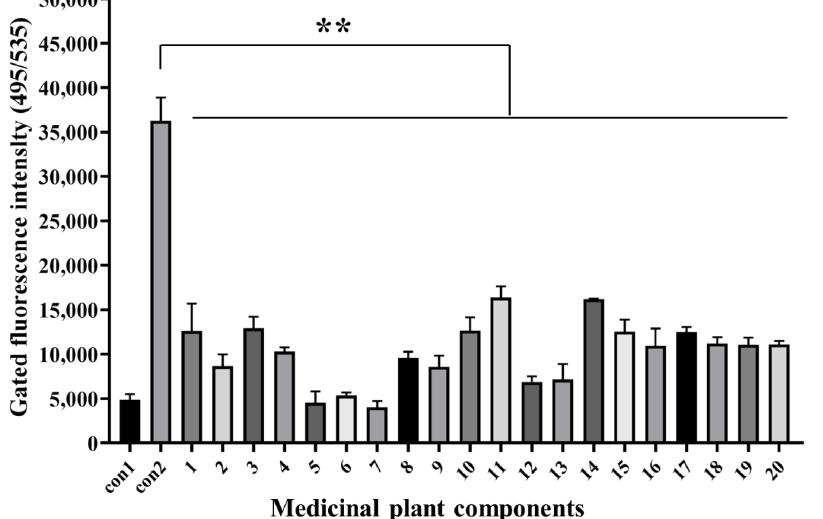
Figure 4. Antiviral analysis of 20 medical plant components against SGIV infection. AHTS results showed that fluorescence of target cells incubated with both SGIV and all components (Nos. 1–20) de- creased obviously. Results are presented as mean ± SD of three independent experiments (** p <